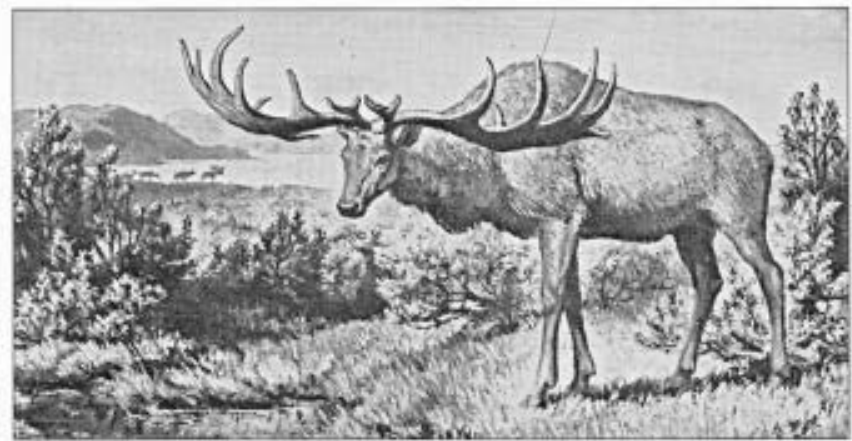
Figure 5 Diorama of giant deer (Megaloceros giganteus) beside a lake in Ireland during the early postglacial period; painted by Marjorie Maitland Ho ward (reproduced from plate 24b in the 4th edition of Dating the past (1958)). mature postgraduates of the early